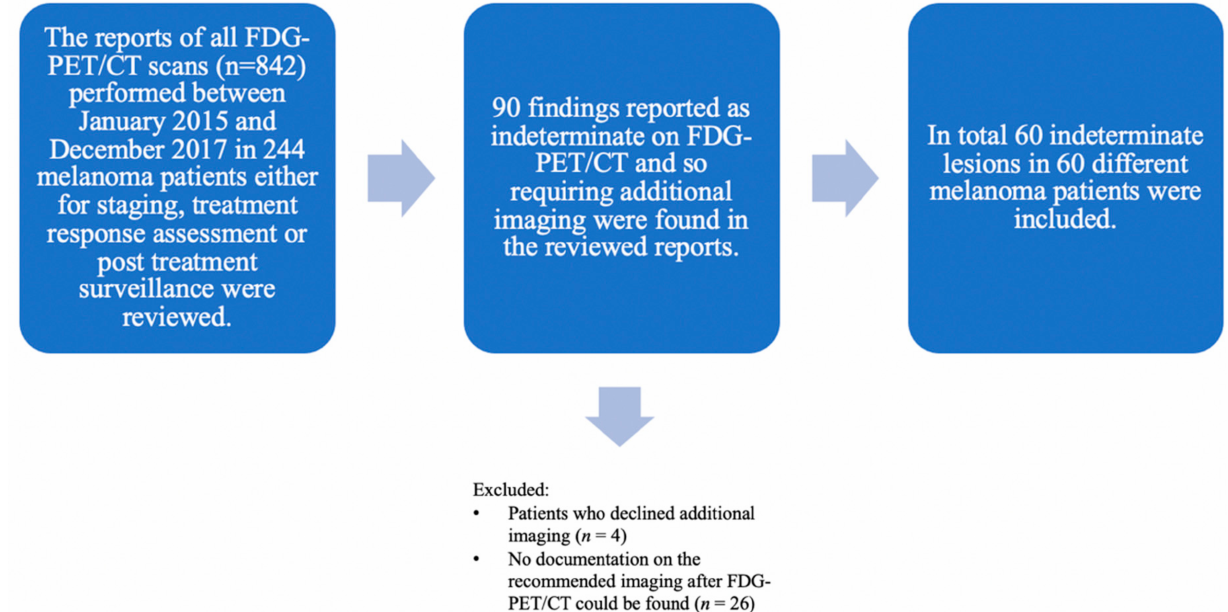
Figure 1. Flowchart showing lesion selection with all included and excluded lesions. The reports of all FDG-PET/CT scans ( n = 842) performed between January 2015 and December 2017 in melanoma patients ( n = 244) in clinical routine either for staging, treatment response assessment or post treatment surveillance were considered. Initially, 90 indeterminate findings on the FDG-PET/CT requiring additional imaging for further evaluation were retrospectively found in the reviewed reports. Lesions were excluded either when patients declined additional imaging ( n = 4) or no documentation on the recommended imaging after FDG-PET/CT could be found ( n = 26). In total, 60 indeterminate lesions were included. All included patients ( n = 60) with histopathologically proven melanoma who were treated at the Department of Dermatology of the University Hospital Zurich—each patient with one indeterminate finding on the